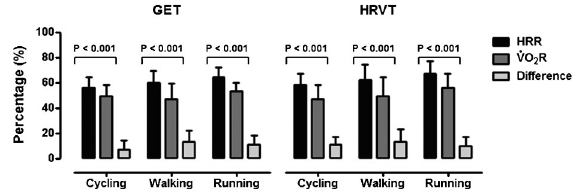
Figure 3. Mean±SD percentage of heart rate reserve (%HRR), : oxygen uptake reserve (% VO 2 R), and difference between : %HRR––% VO 2 R at the gas exchange threshold (GET) and heart rate variability threshold (HRVT) (n=16). Sidak-adjusted P values : indicate significant differences between %HRR and % VO 2 R .